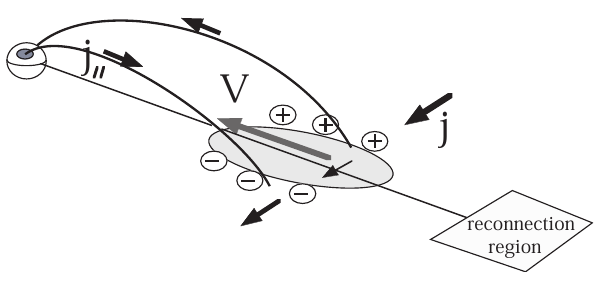
Fig. 18. Illustration of the plasma bubble model (Chen and Wolf, 1993) and associated field aligned currents (Adapted from Naka- mura et al.,